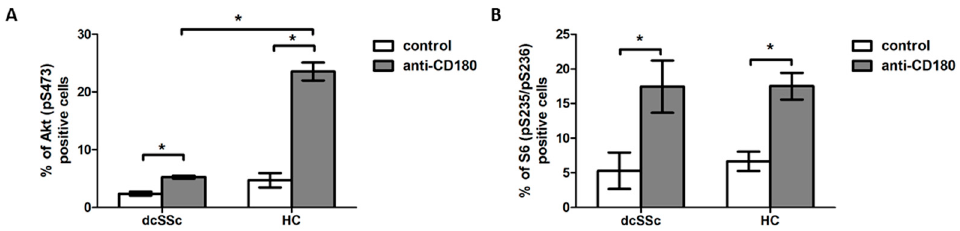
Figure 1. Induction of phosphorylation of Akt and S6 by CD180 ligation. Changes in the phosphory- lation of Akt (pS473) ( A ) and S6 (pS235/pS236) ( B ) molecules in purified B cells of diffuse cutaneous SSc (dcSSc) patients ( n = 6) and healthy controls (HCs) ( n = 7) after stimulation with anti-CD180 antibody or left unstimulated (control) for 30 min, detected by flow cytometry. Data are presented as means ± SEM. * p < 0.05.